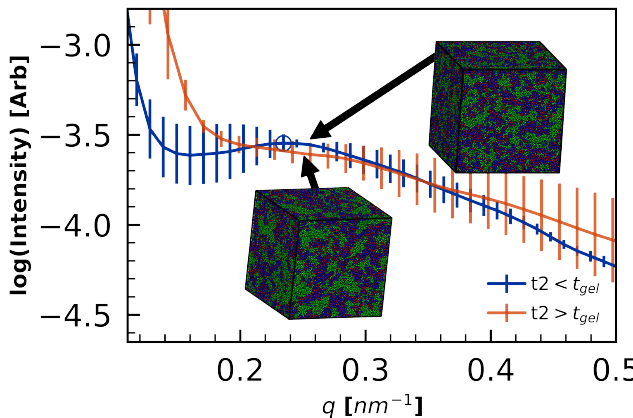
Figure 11. PES-PES structure factor shows difference in morphology as a result of varying t 2 of the “Step” curing profile. Both simulation volumes are cured to α = 0.855. Error bars represent standard error from the three replicate simulations. The length scales of microphase separation are much smaller in the pre-gelation quench (blue), whereas S ( q ) diverges around q L / 2 = 0.17 nm − 1 , indicating a higher degree of phase separation that is apparent in the more distinct clumping of the inset